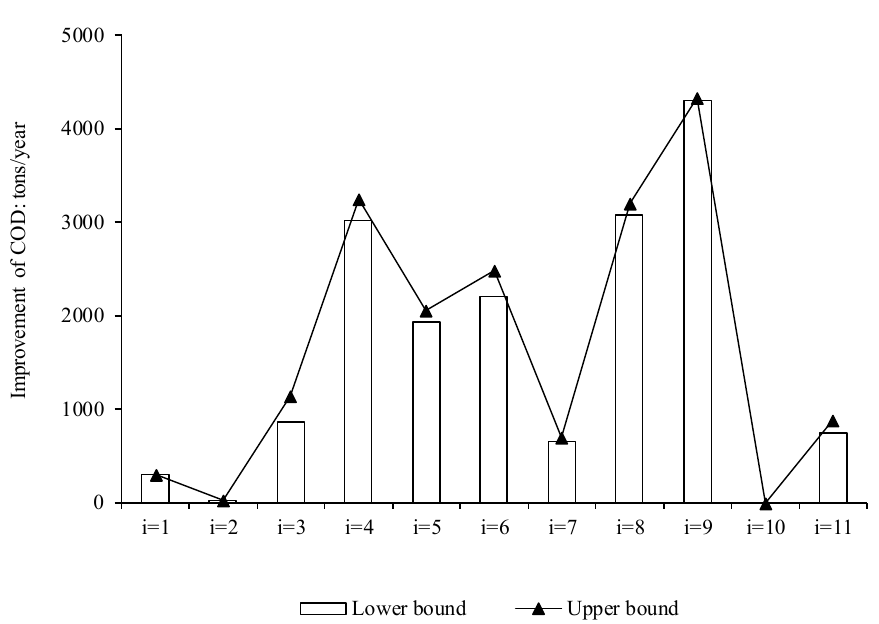
Figure 9. Improvements in COD carrying capacity for the Yinma River.